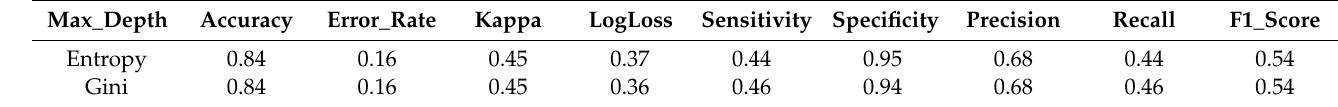
Table 7. Metrics for splitter parameter.